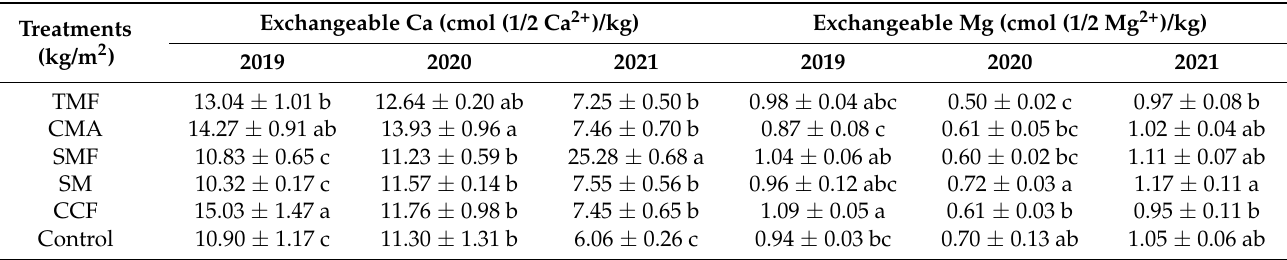
Table 5. Effects of different microbial fertilizers on the exchangeable Ca and exchangeable Mg in newly reclaimed